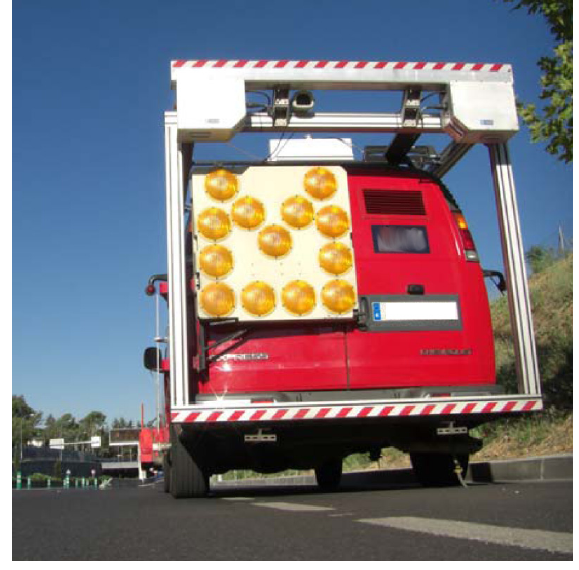
Figure 1. Rear of the vehicle used to acquire and store the road images.